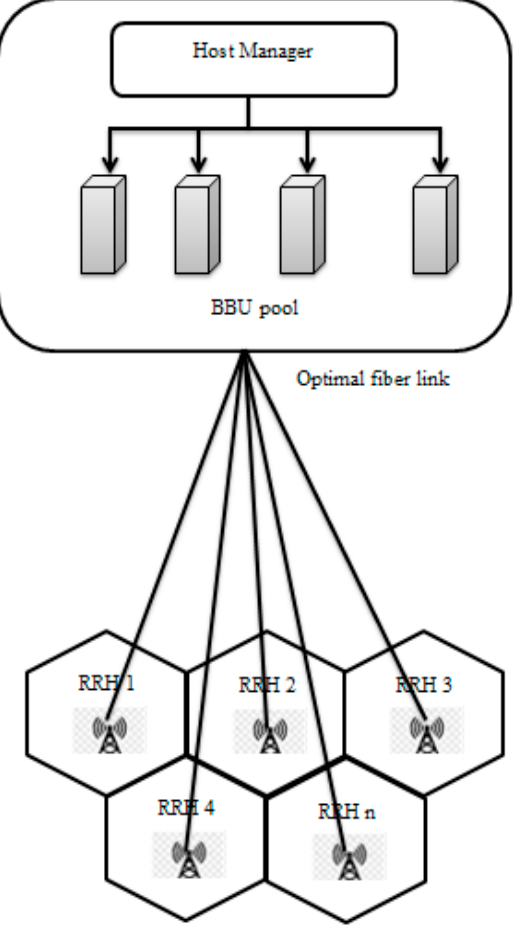
Figure 1. Cloud-RAN system model.